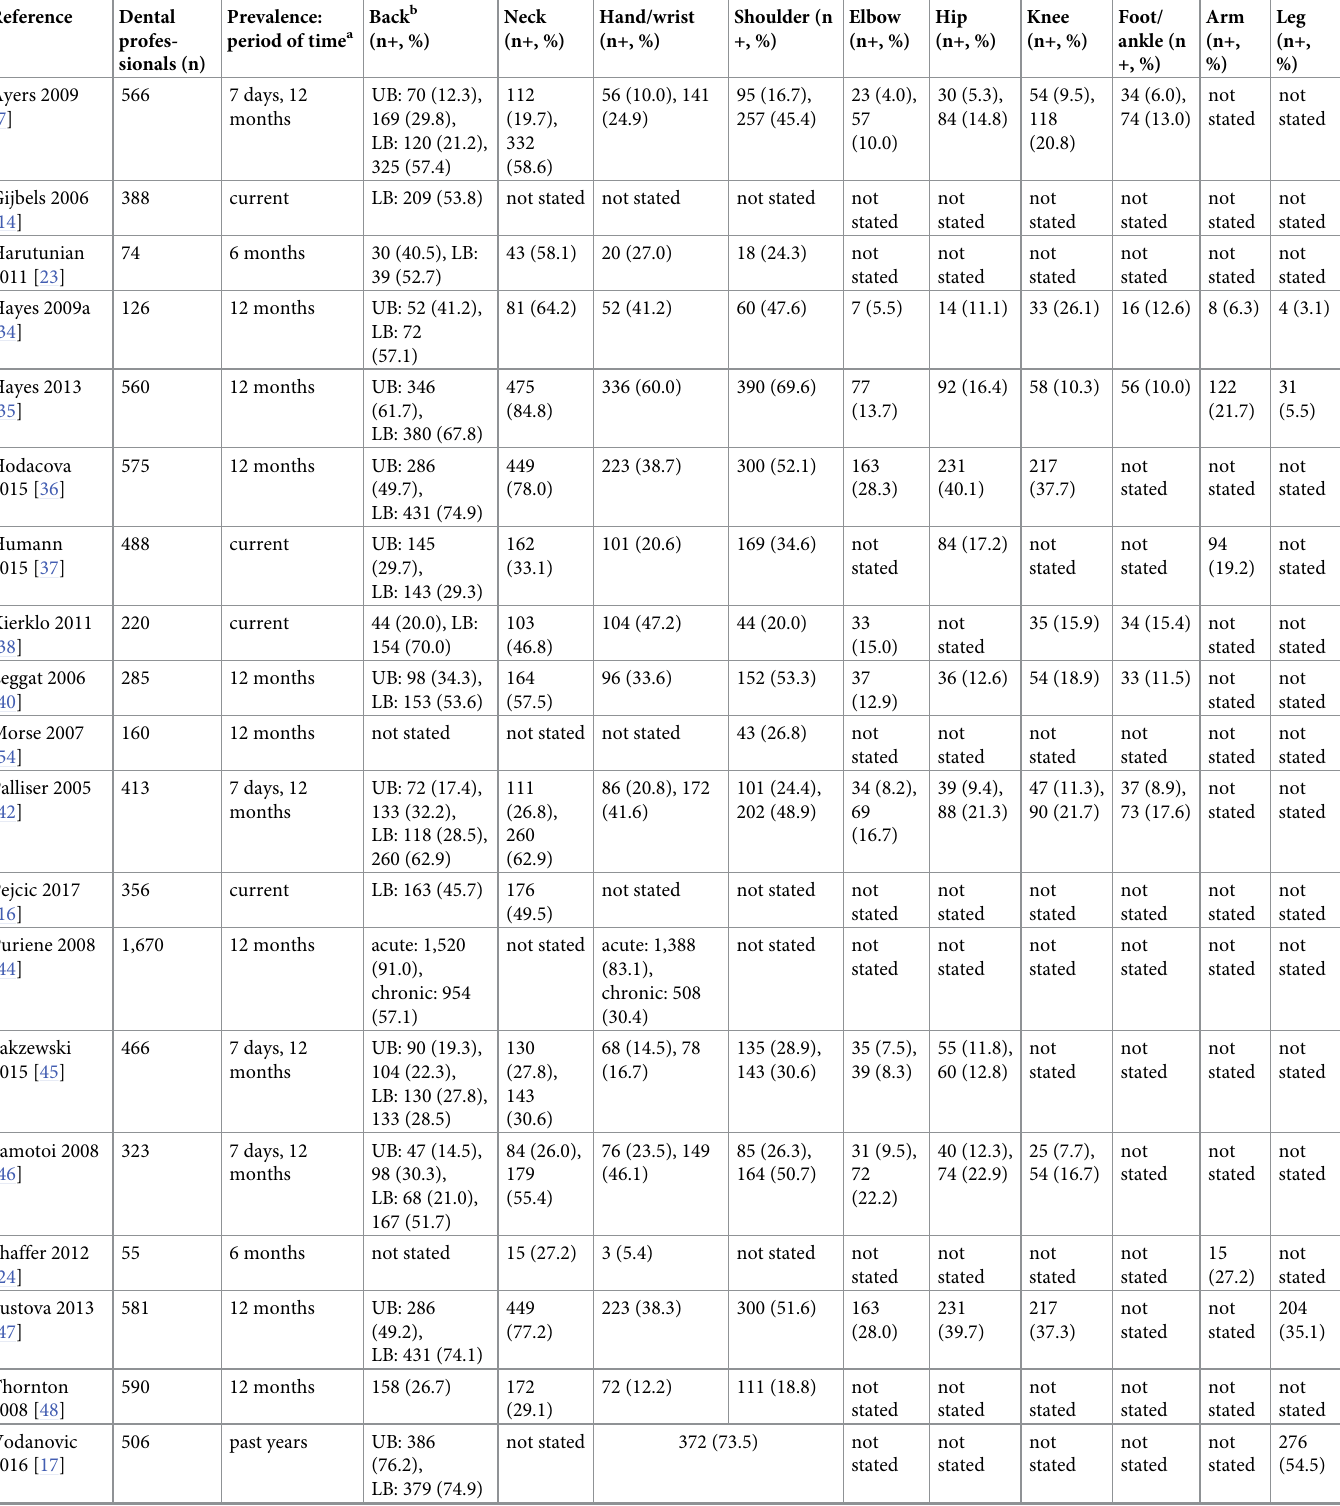
Table 3. Selected studies analyzing the prevalence of MSDs/MSP among dental professionals stratified by body region and period of time (n = 23).